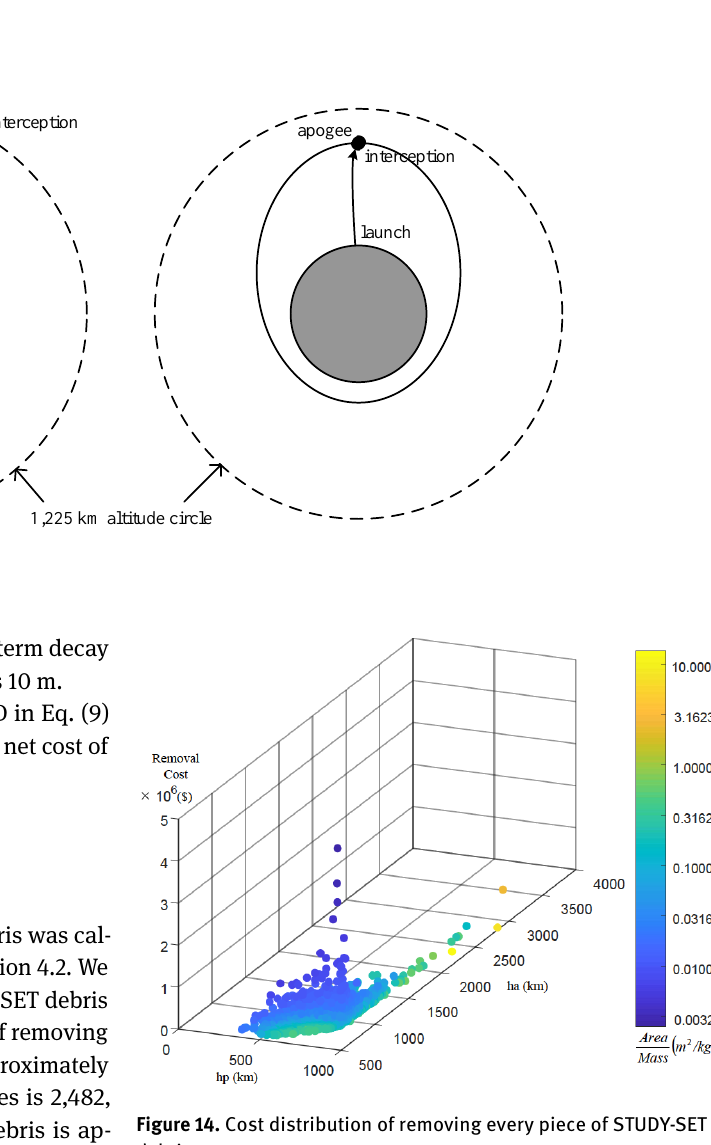
Figure 14. Cost distribution of removing every piece of STUDY-SET debris